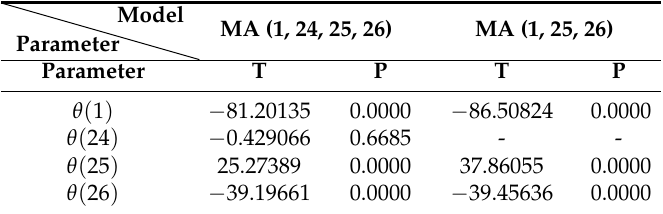
Table 13. Parameter significance test of MA (1, 24, 25, 26) and MA (1, 25, 26).